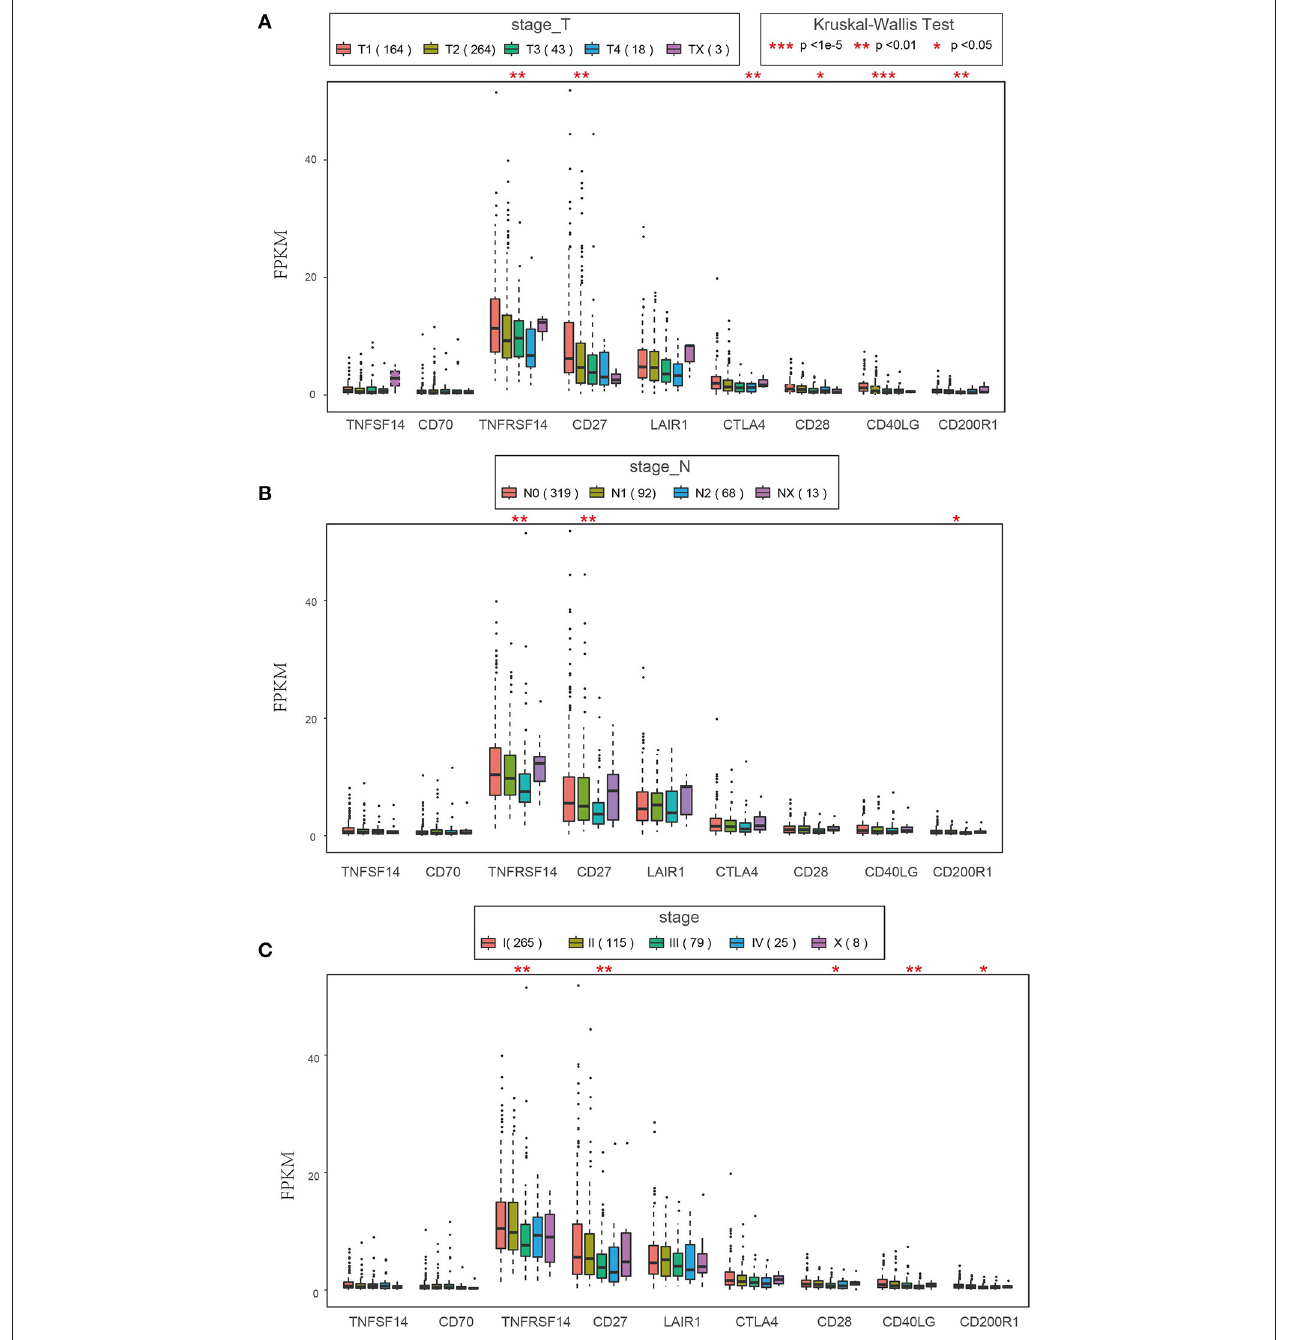
FIGURE 7 | (A) Box diagram of nine ICGs’ expression in different T stages (FPKM); (B) Box diagram of nine ICGs’ expression in different N stages (FPKM); (C) Box diagram of nine ICGs’ expression in different Stages (FPKM). The Abscissa represents the ICGs, and the ordinate represents the expression of ICGs in different T/N/Stages. The test method is Kruskal-Wallis Test. * P < 0.05; ** P < 0.01; *** P <